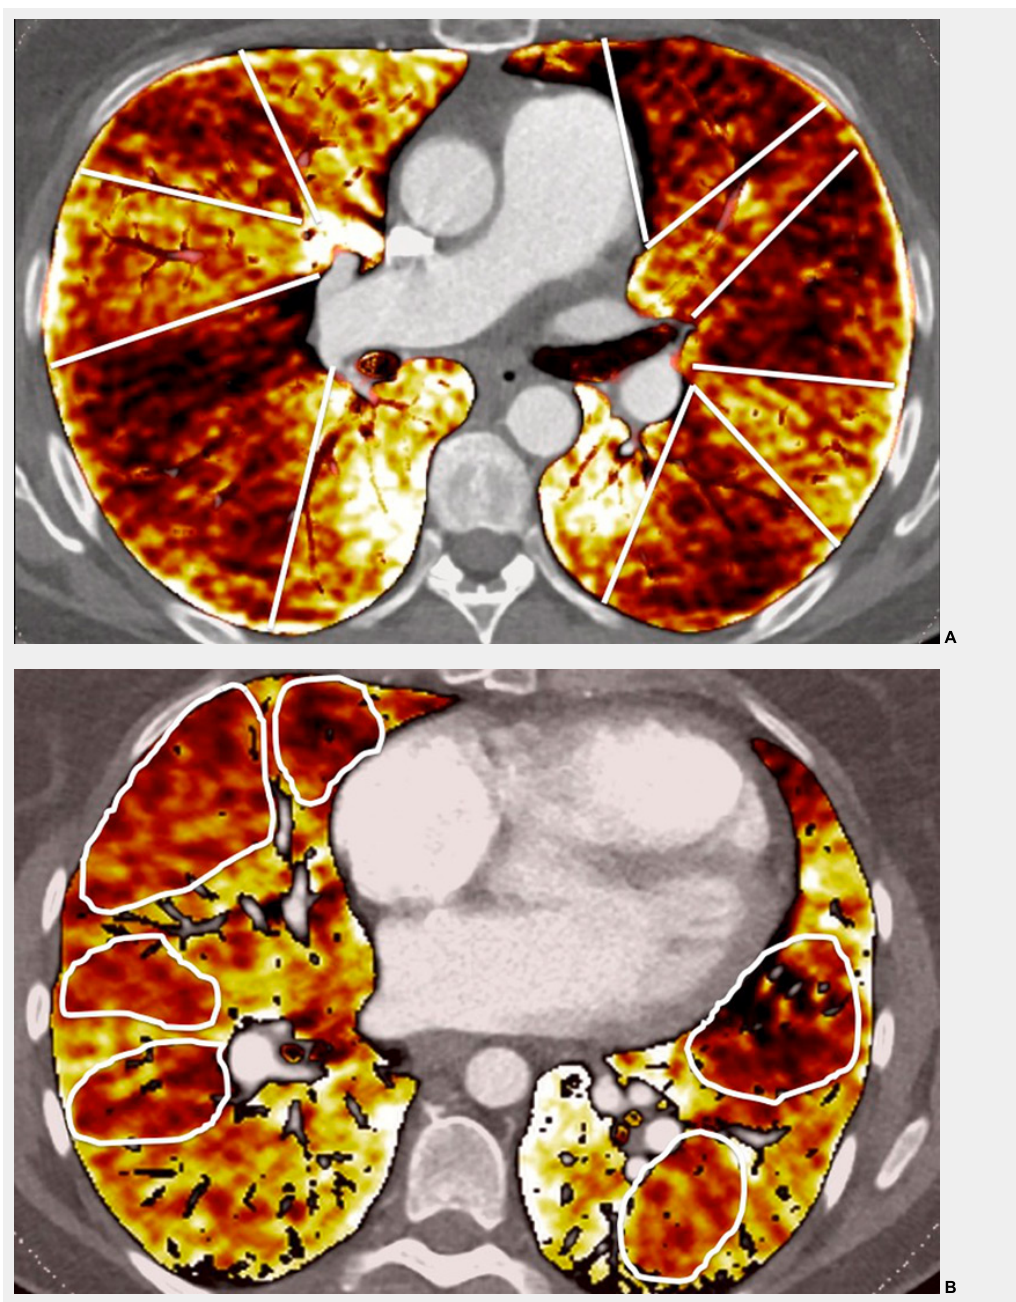
Figure 5 Difference of perfusion defects in pulmonary hypertension depending on the aetiology: triangular well-defined defect seen in chronic thromboembolic pulmonary hypertension ( A ) and poorly defined defect with mottled pattern seen in idiopathic pulmonary arterial hypertension ( B